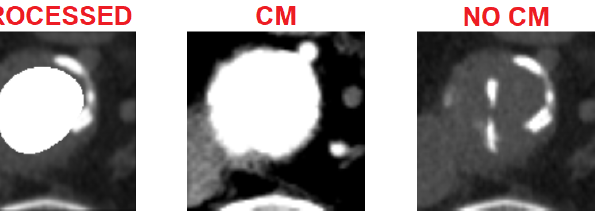
Figure 18. Case of floating thrombus that does not affect the functioning of the algorithm, which manages to extract the patent